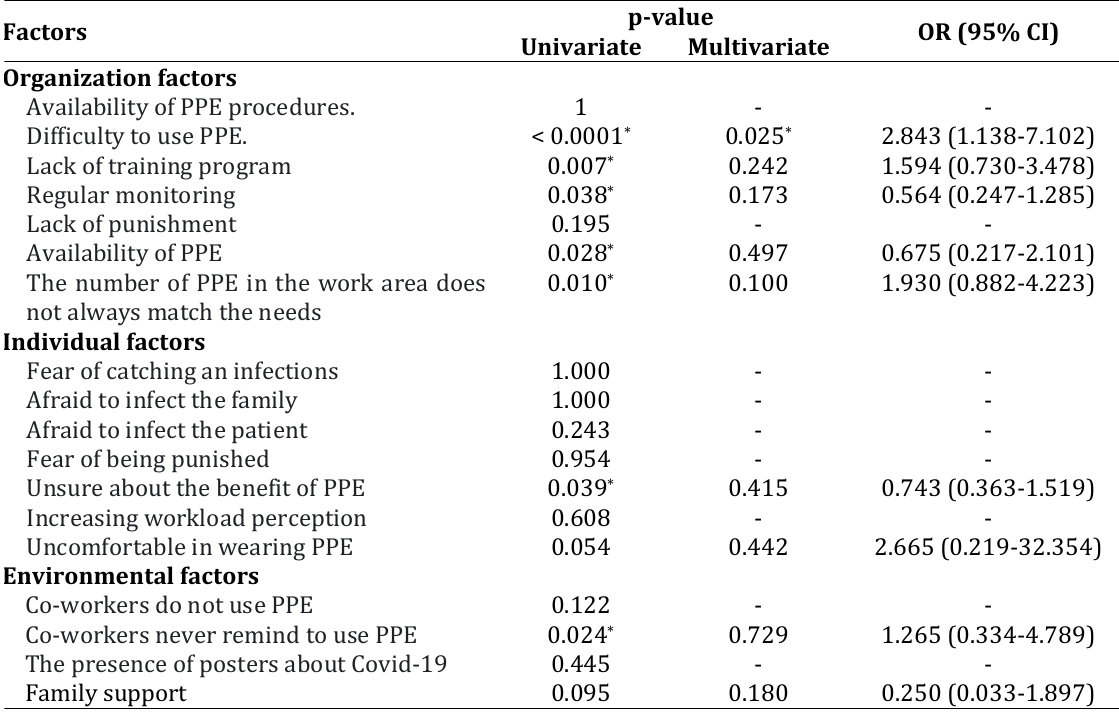
Table V. Factors influencing the compliance to PPE use